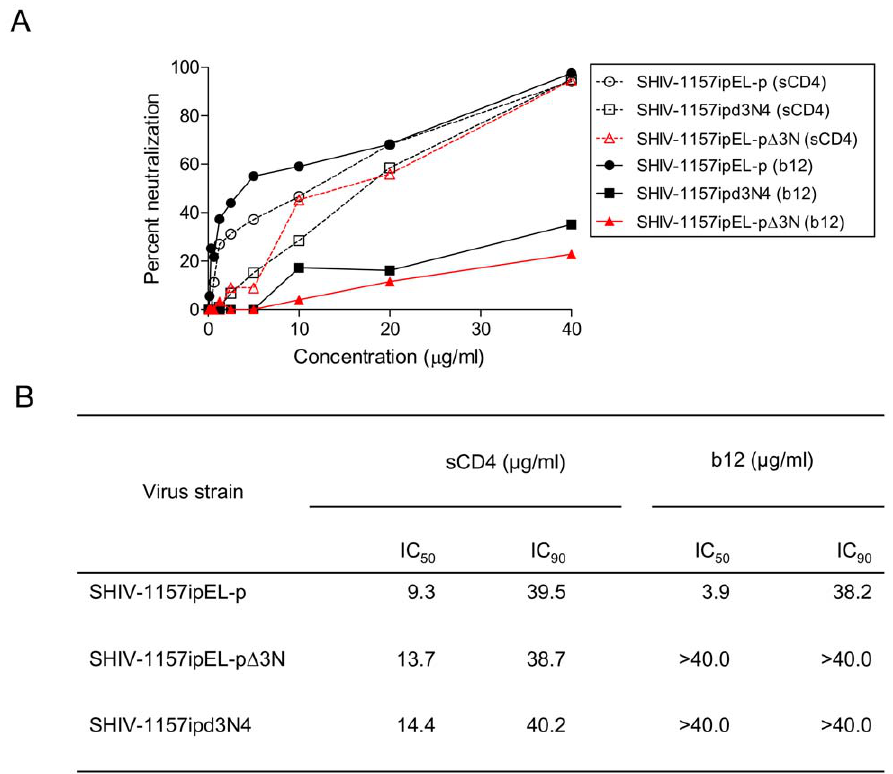
Figure 6. Neutralization of SHIV-1157ipEL-p, SHIV-1157ipEL-p D 3N and SHIV-1157ipd3N4 by sCD4 and b12. The assays were performed in TZM-bl cells using virus stocks grown in RM PBMC. (A) Dotted lines, neutralization of SHIV-1157ipEL-p (circles), SHIV-1157ipEL-p D 3N (red color with triangles) and SHIV-1157ipd3N4 (squares) using sCD4; solid lines, neutralization of the above SHIVs using the human nmAb b12. (B) Values represent the concentration ( m g/ml) for sCD4 and human b12 at which relative luciferase units (RLU) were reduced 50% or 90% compared to virus control wells, respectively.